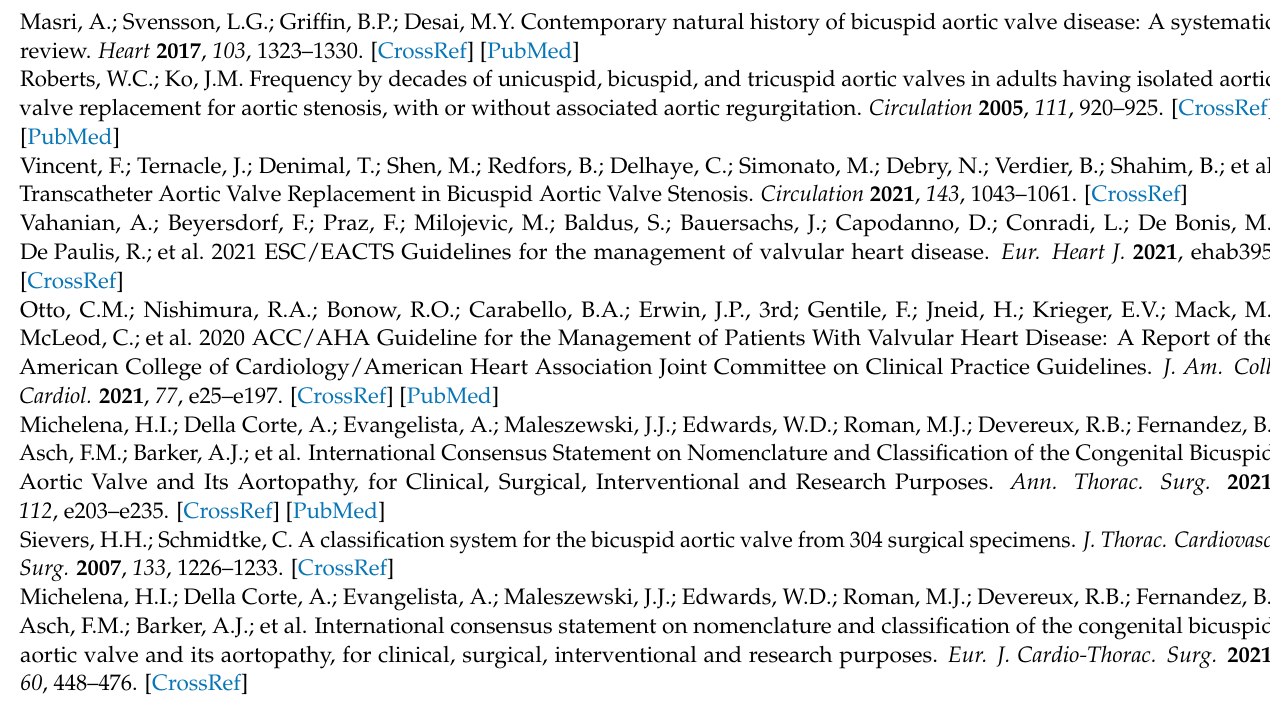
Table S2: the collaborating centers and number of patients of the Myval bicuspid